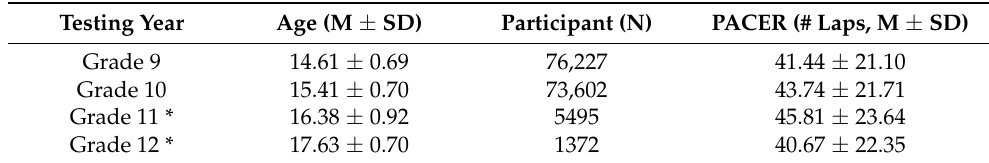
Table 1. Participation information for PACER testing age and